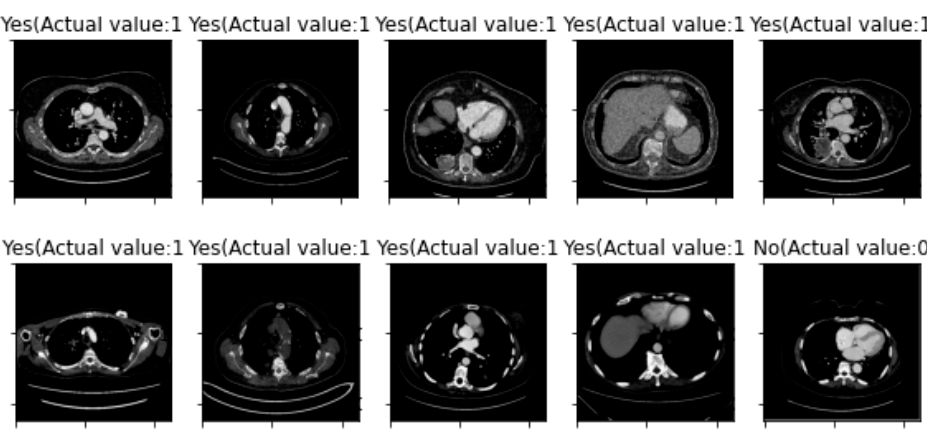
Table 2. Classification statistics for the first and second runs. Figure 5. Example of outputs from the first run. The following table, Table 2, shows the statistics from the first and second runs.